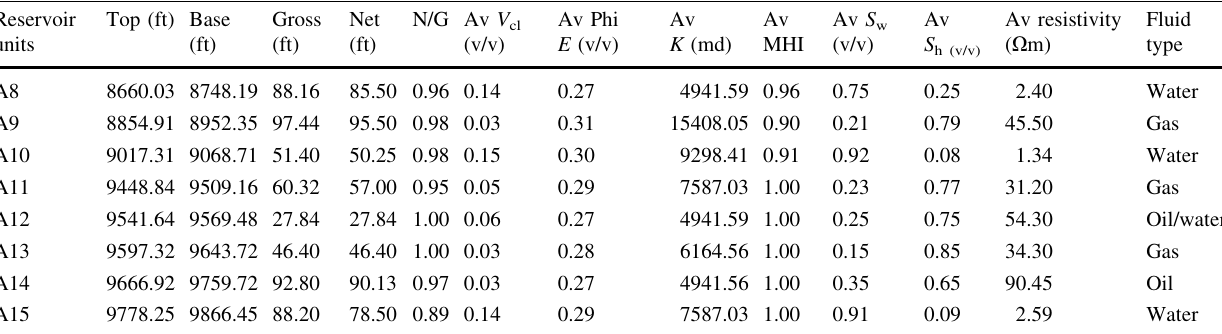
Table 4 Average petrophysical parameters for the reservoirs in JAP-3 well Reservoir units